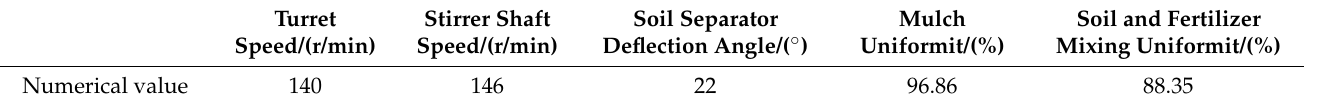
Table 7. Optimal parameter combination scheme.